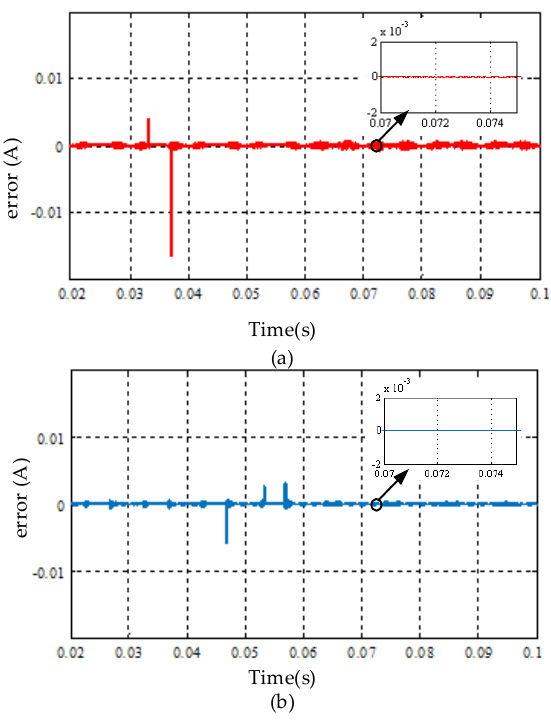
Figure 12. The difference of the two primary currents after the two current sharing controllers: ( a ) PI current sharing control; ( b ) sliding mode current sharing control.